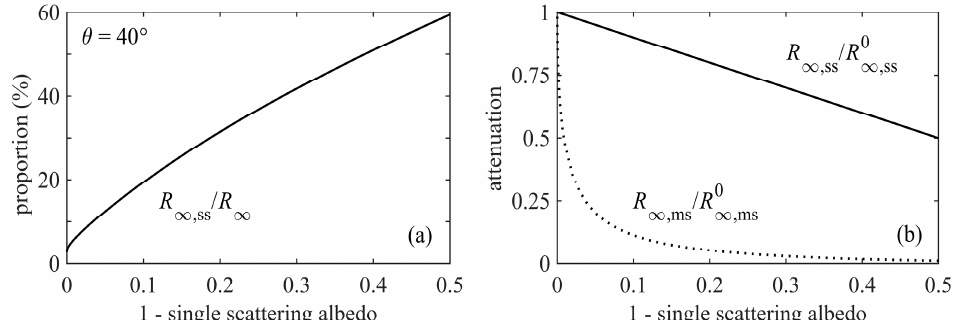
Figure 2. ( a ) The proportion of the single-scattering part increases during absorption enhancement. ( b ) The curve of absorption attenuation is very di ff erent between the single- and multi-scattering parts. The single-scattering part ( R 0 ∞ ,ss , R ∞ ,ss ) was calculated according to the definition of single-scattering. The cloud reflectance ( R 0 ∞ , R ∞ ) was calculated by DISORT. The multi-scattering part ( R 0 ∞ ,ms , R ∞ ,ms ) is the di ff erence between the cloud reflectance and the single-scattering part.